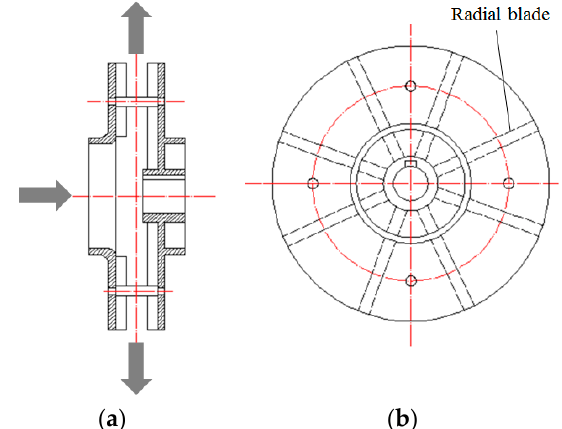
Figure 14. Example on particular impeller new design for two ‐ phase flow inlet conditions: ( a ) meridional view; ( b ) blade to blade